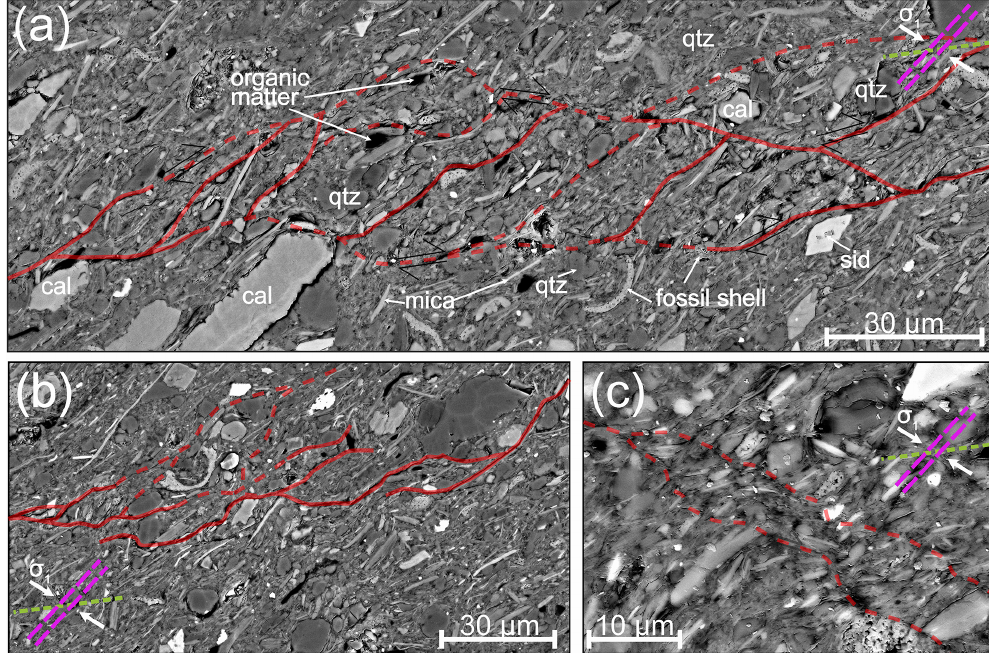
Figure 5. BIB–SEM (BSE) micrographs showing typical deformation structures associated with both brittle and ductile deformation. Red lines indicate strain localisation in the form of fractures (a, b) or lineations of shear displacement (c) . (a) Anastomosing intergranular fractures with apertures of some micrometres formed lens-shaped islands, whereas some grains displayed intragranular fractures. Panel (b) shows fractures with intergranular porosity, which formed a network that is not fully developed with minor indications of ductile deformation by clay-layer bending. Panel (c) shows a deformation band with low porosity and predominantly ductile deformation indicated by the change in particle